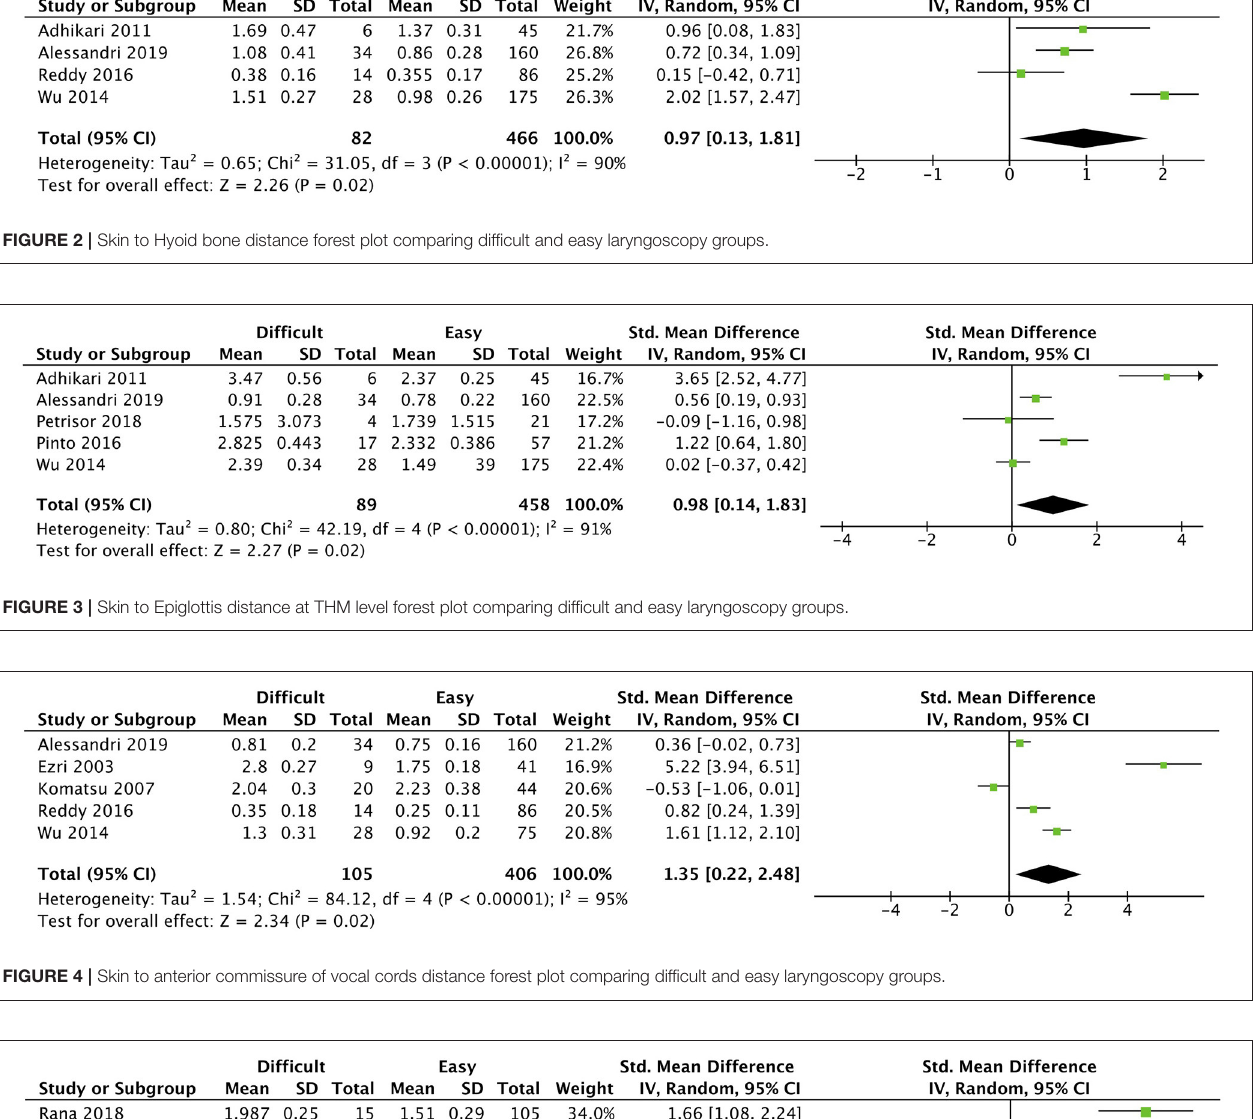
Petrisor et al. (23) established that values equal or inferior to 5.50 cm (Se: 100%, Sp: 71.4%), predicted a difficult laryngoscopy. The overall effect of this measurement was significant ( p = 0.0002) ( Figure 9 ).